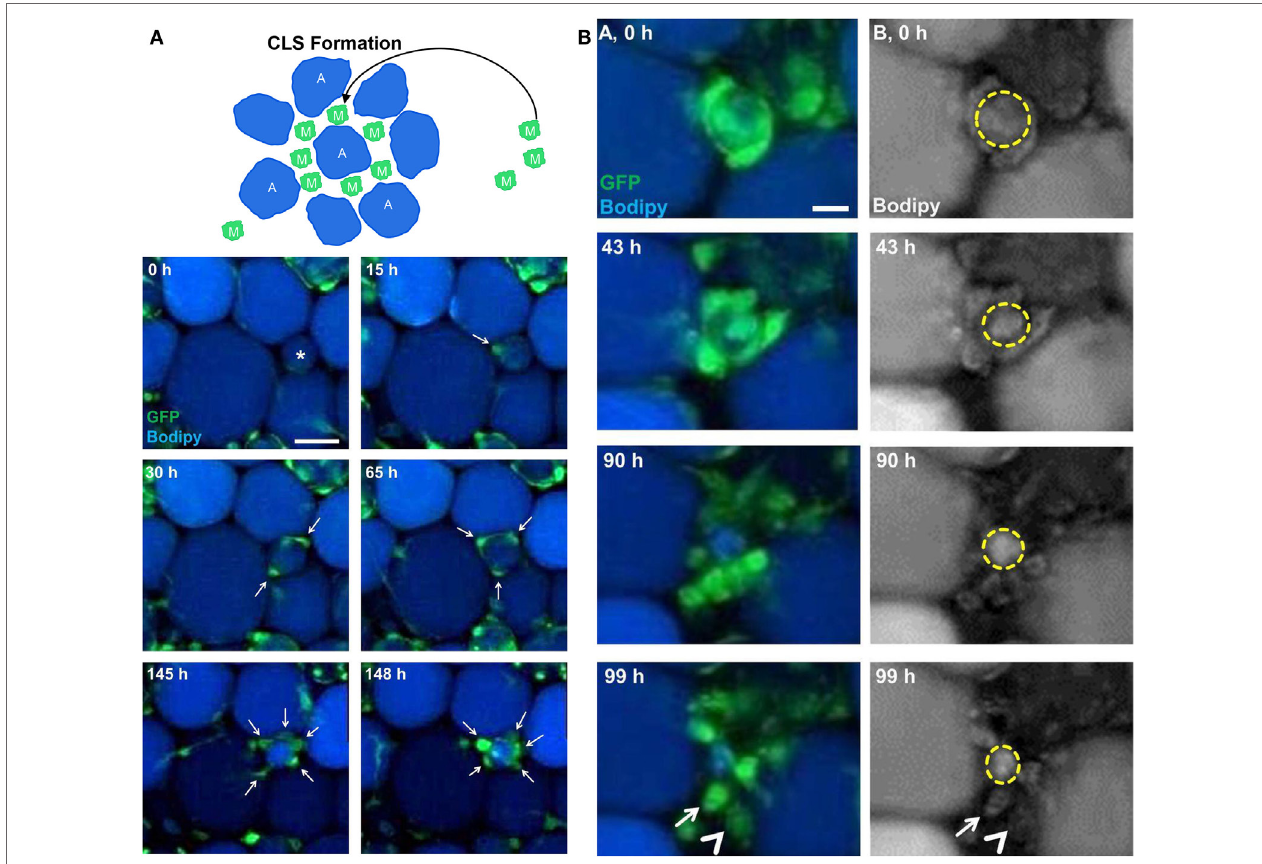
FiGURe 4 | Imaging macrophages in the context of obesity. (a) Long-term imaging showed that enhanced green fluorescent protein (EGFP)-expressing macrophages ( M ) migrated toward and accumulated around dying adipocytes ( A ) stained with BODIPY to form crown-like structure (CLS) in ex vivo cultured adipose tissue explants from a mouse (reproduced under the terms of the CC BY 4.0 license, Copyright © 2015 the American Physiological Society) (92). (b) EGFP- expressing macrophages were involved in degradation of dead adipocytes in adipose tissue explants from a mouse (reproduced under the terms of the CC BY 4.0 license, Copyright © 2015 the American Physiological Society)